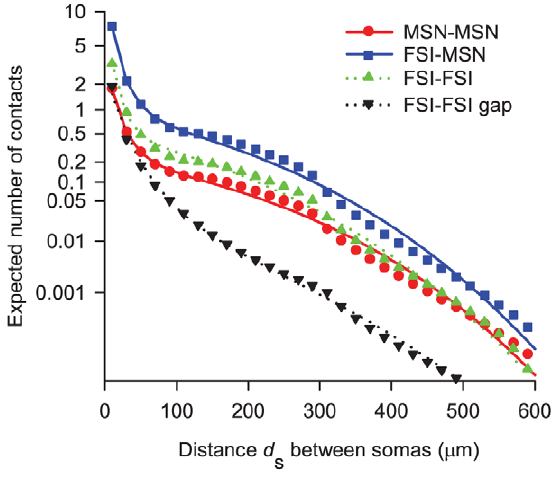
Figure 7. Expected number of intersections occurring as a function of the distance between the somas of two neurons. Symbols give the numerically determined predictions of the dendrite and axon models. Lines give the best-fit functions of the form in equation (20), for use in constructing networks.